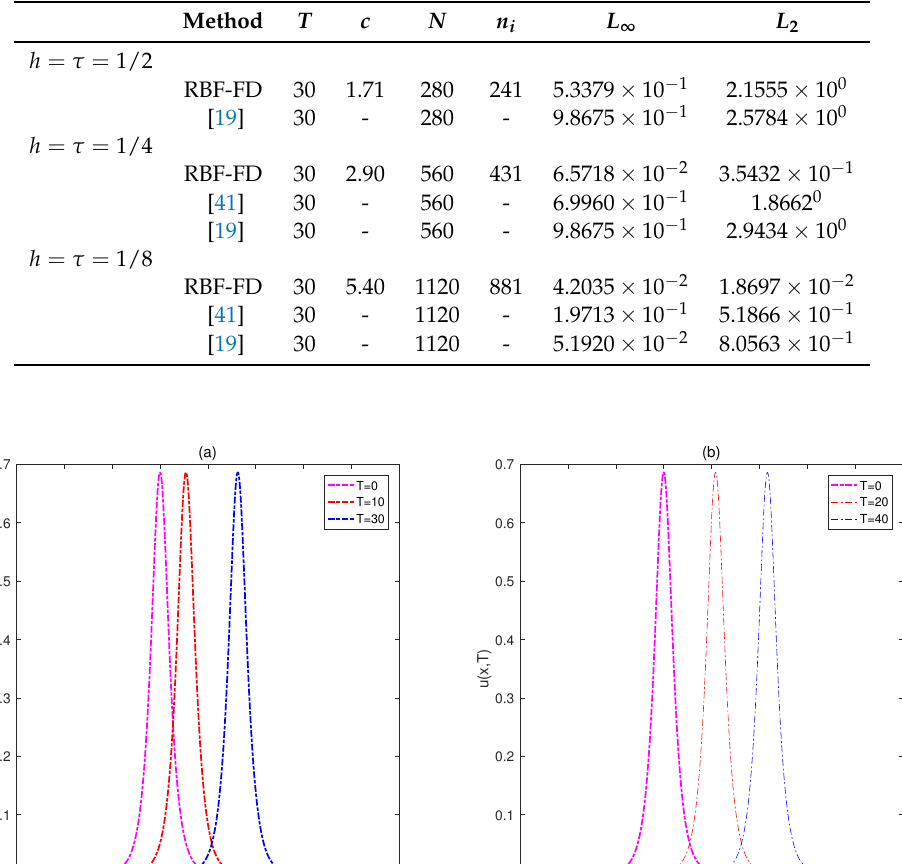
Table 6. The L ∞ and L 2 errors under different mesh steps h = τ for Example 3.